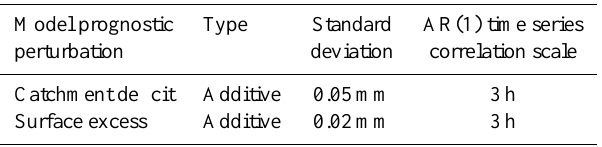
Table 2. Parameters for perturbations to the CLSM prognostic